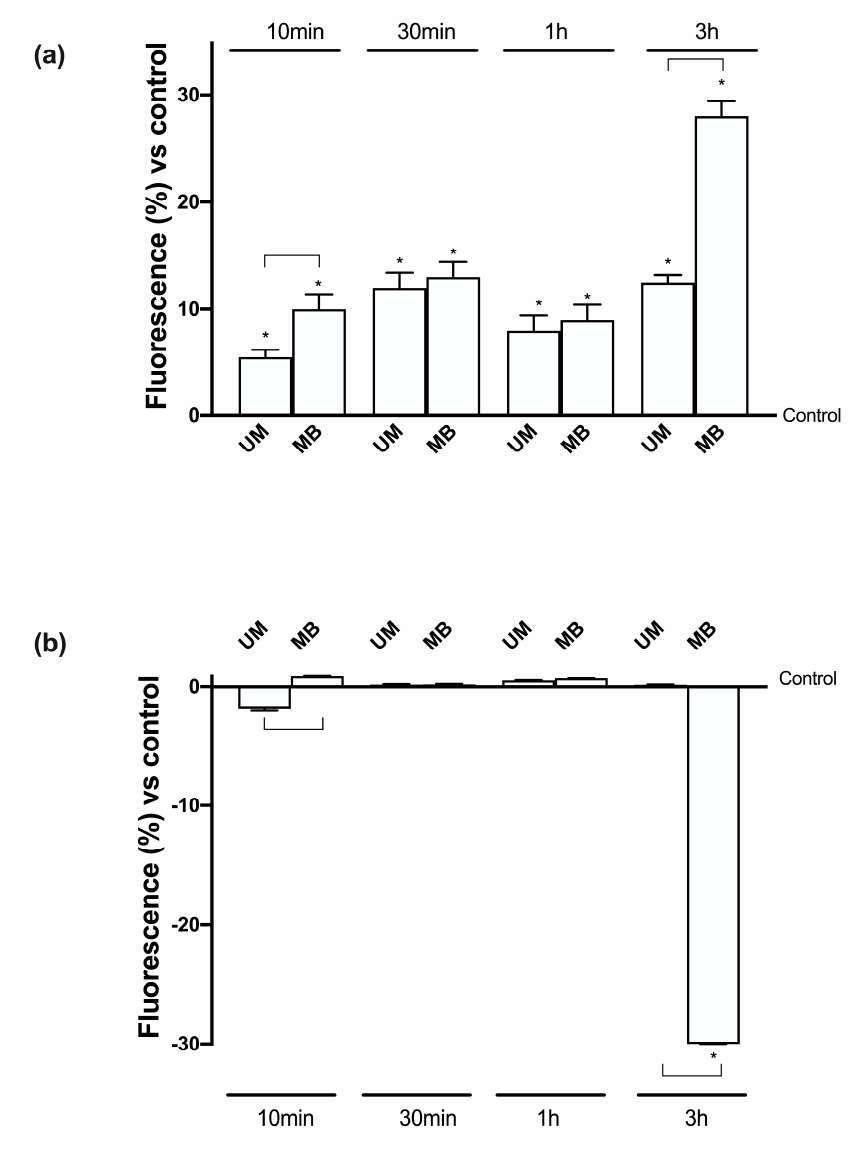
Figure 3. Measurements of Mg 2 + and Ca 2 + flux on Caco-2 cells. ( a ) Free intracellular magnesium concentration ([Mg 2 + ]i) as measured before (basal [Mg 2 + ]i) and after Mg-loading by UM and MB. After measurement of the basal [Mg 2 + ]i in Na- and Mg-free medium, Caco-2 cells were Mg-loaded by Furaptra, and post-loading [Mg 2 + ]i was calculated from the values measured over time. ( b ) Free calcium concentration ([Ca 2 + ]) as measured before (basal) and after Mg-loading by UM and MB. After measurement of the basal [Ca 2 + ] in Na-, Ca-, and Mg-free medium, Caco-2 cells were loaded with by Fura2, and post-loading [Ca 2 + ] was calculated from the values measured during time. Values are means ± SD (%) of six single experiments. * p < 0.05 vs. control; the bars indicate p < 0.05 between UM and MB at the same time point.